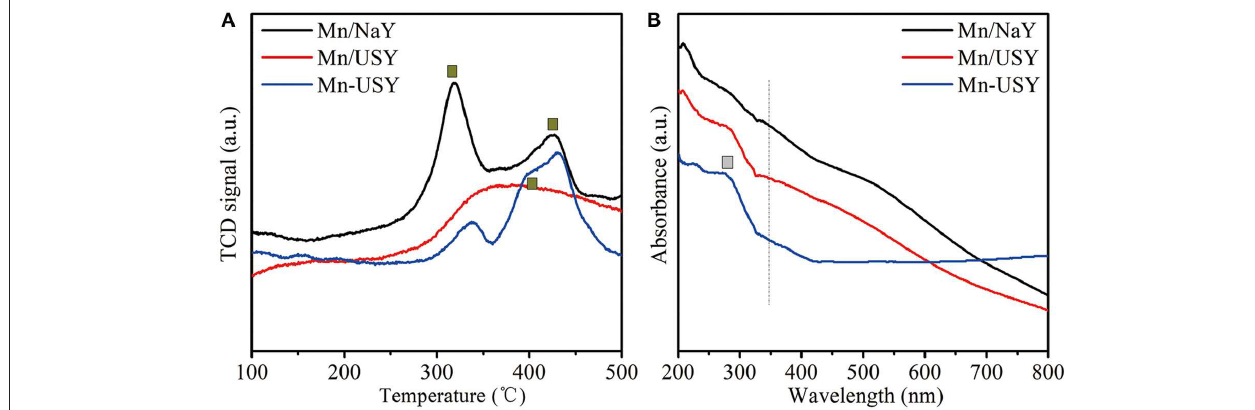
FIGURE 4 | H 2 -TPR (A) and UV-vis (B) spectra of Mn/NaY, Mn/USY, and Mn-USY.